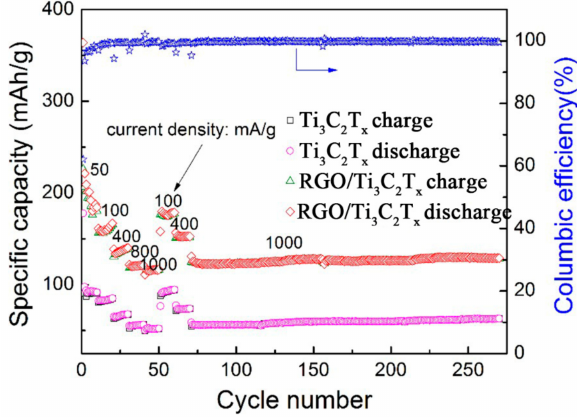
Figure 6. Rate performance of Ti 3 C 2 T x and the RGO/Ti 3 C 2 T x nanocomposite at different current